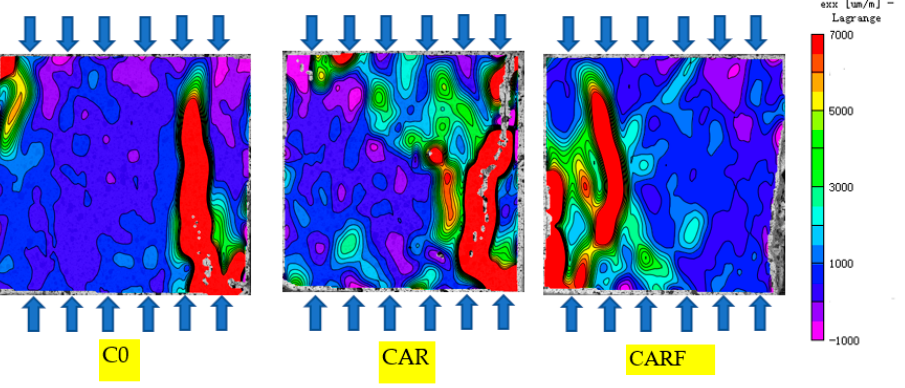
Figure 6. The ratios of flexural strength to compressive strength ( f f / f c ) of specimens incorporating toughening materials.